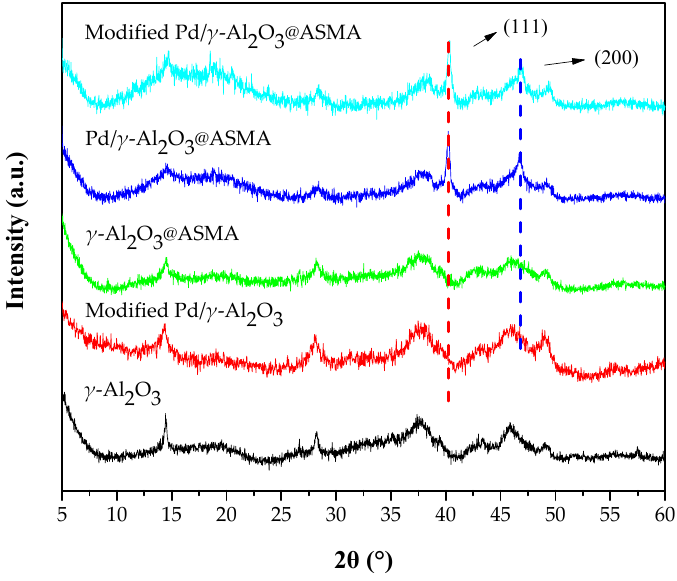
Figure 2. XRD (X ‐ ray diffraction) patterns of catalyst and intermediates. Figure 2. XRD (X-ray diffraction) patterns of catalyst and